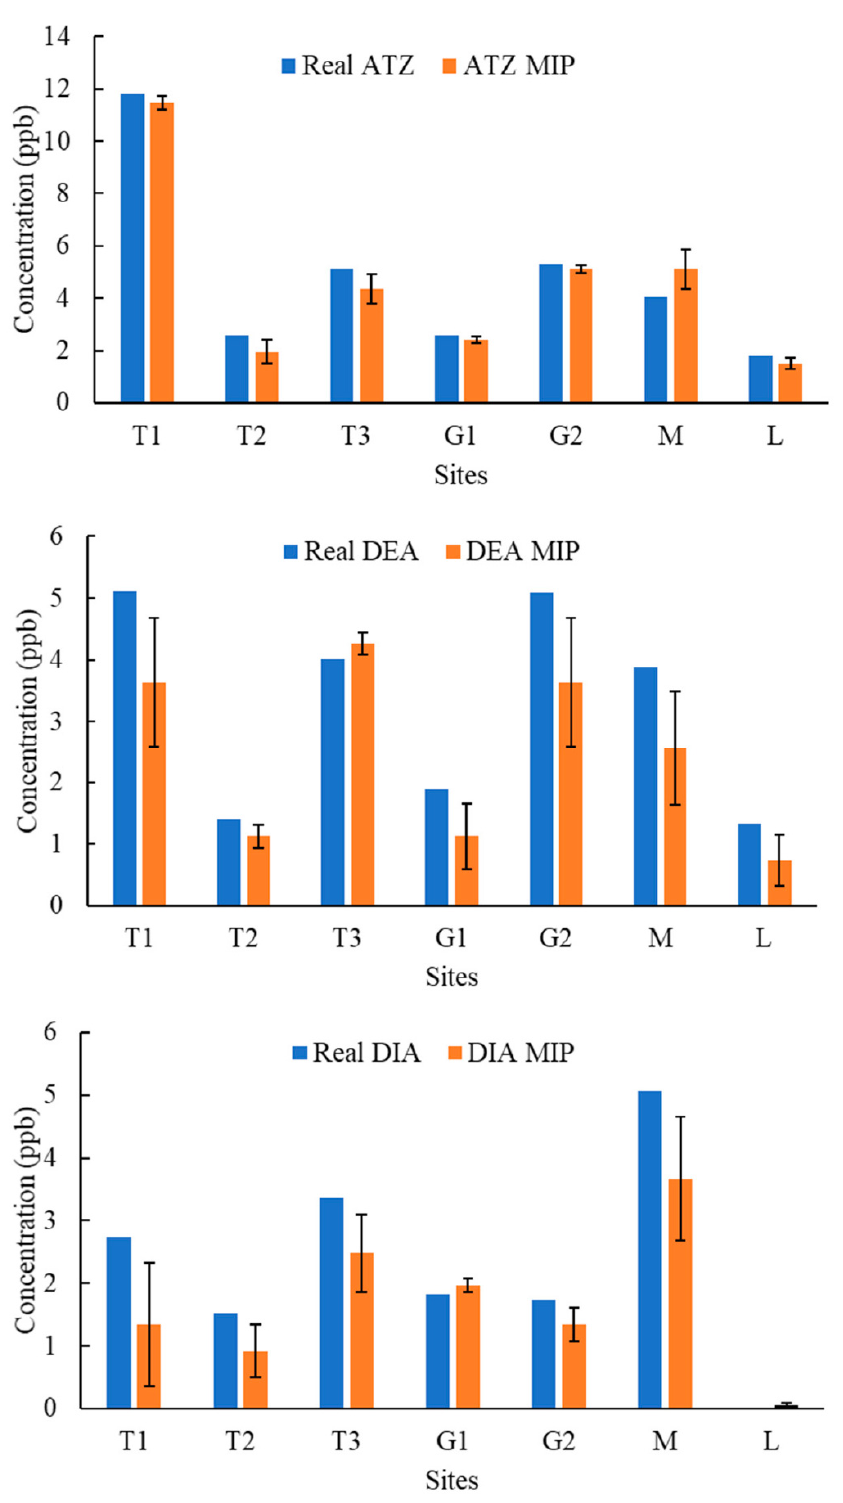
Figure 6. Average response of MIPs to ATZ, DEA, and DIA compared to real concentrations validated by LCMS/MS for samples of 10 June 2020.